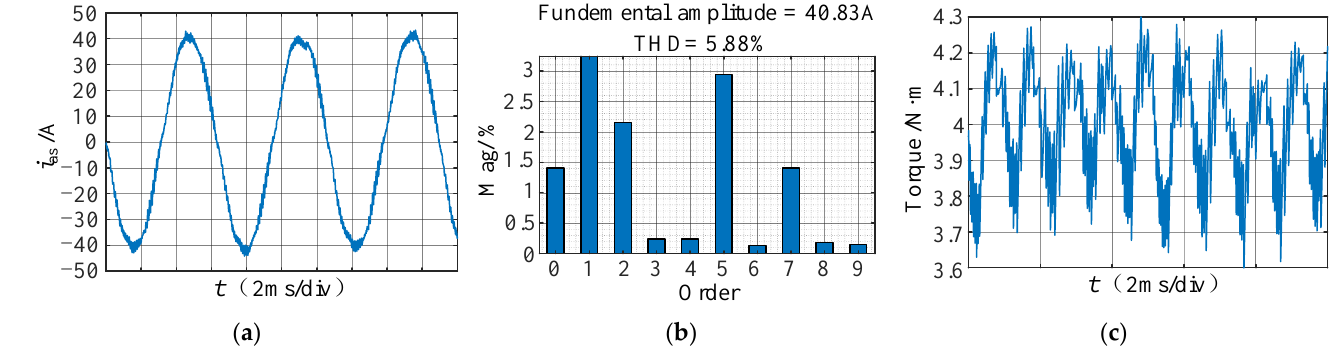
Figure 16. Simulation results under no compensation. ( a ) i as ; ( b ) FFT; and ( c ) output torque.